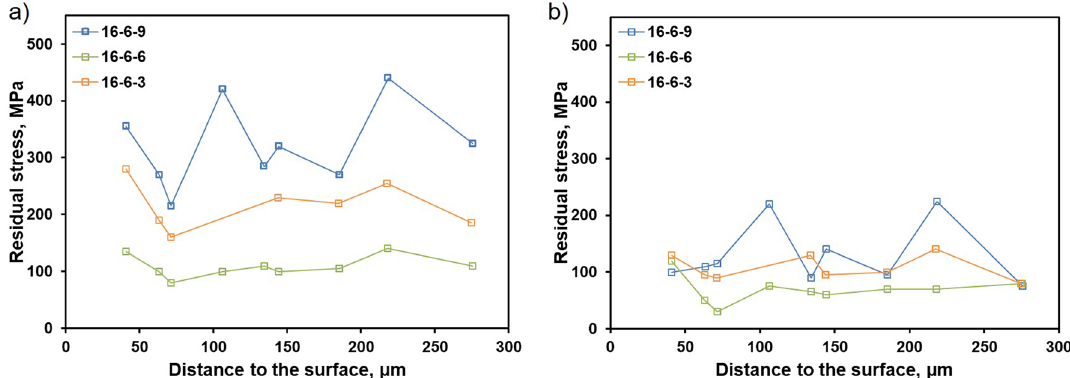
Figure 2. Near surface residual stress distribution determined as a function of distance to the surface by ED-XRD analysis for PBF-LB/M material of all three steels with respect to BD ( a ) as well as in TD ( b microstructure (Fig. 1a). Individual grains exceed the size of several hundred microns with a width of about 100 µm. The steel with 6 wt.% nickel content, shown in Fig. 1b, is characterized by a different microstructure with refined, randomly textured grains (cf. Supplementary data Fig. S2). Still, prevailing grains are slightly aligned following the shape of the preceding individual melt pools (these being indirectly visible in the map). For the additively manufactured 16-6-3 shown in Fig. 1c, the microstructure is composed of two different characteristic features. On the one hand, U-shaped coarse grains without pronounced texture are formed (pinpointing a melt pool width of about 100 µm). On the other hand, fine grains and needles, respectively, occur with different sizes. These features are either bundled alongside the preceding melt pool boundaries or intersecting the U-shaped grains. In addition to the orientation maps, phase maps obtained by EBSD are depicted (Fig. 1d–f). With respect to accuracy and resolution of EBSD data, it is found that the steel with 9 wt.% Ni seems to be fully austenitic (Fig. 1d), whereas the PBF-LB/M-16-6-6 material shows a fcc microstructure with a small amount of ε-martensite (being indexed as hexagonal closed-packed (hcp) phase) in Fig. 1e. In contrast, the major fraction of the PBF- LB/M-16-6-3 material is bcc. Here, the bcc matrix is intermingled with fcc and hcp phases as shown in Fig. 1f. BD and in transversal direction (TD) are shown in Fig. 2a and b, respectively. The stresses in normal direction are considered to be zero due to the plane-stress condition prevailing at free surfaces. In BD, the different alloys